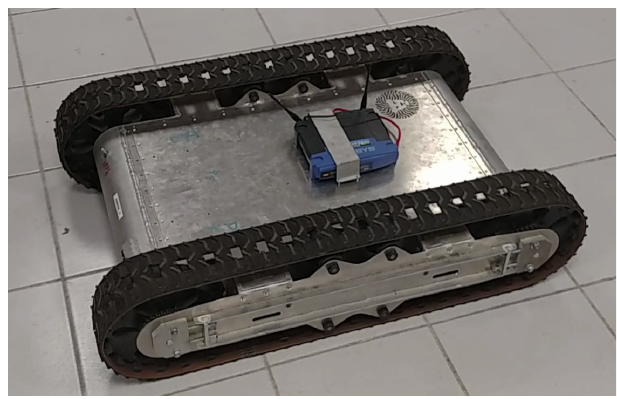
Figure 3. Modified HD2 R (cid:13) Treaded All-Terrain Tracked Robot (ATR) Tank Robot Platform with wireless communication.